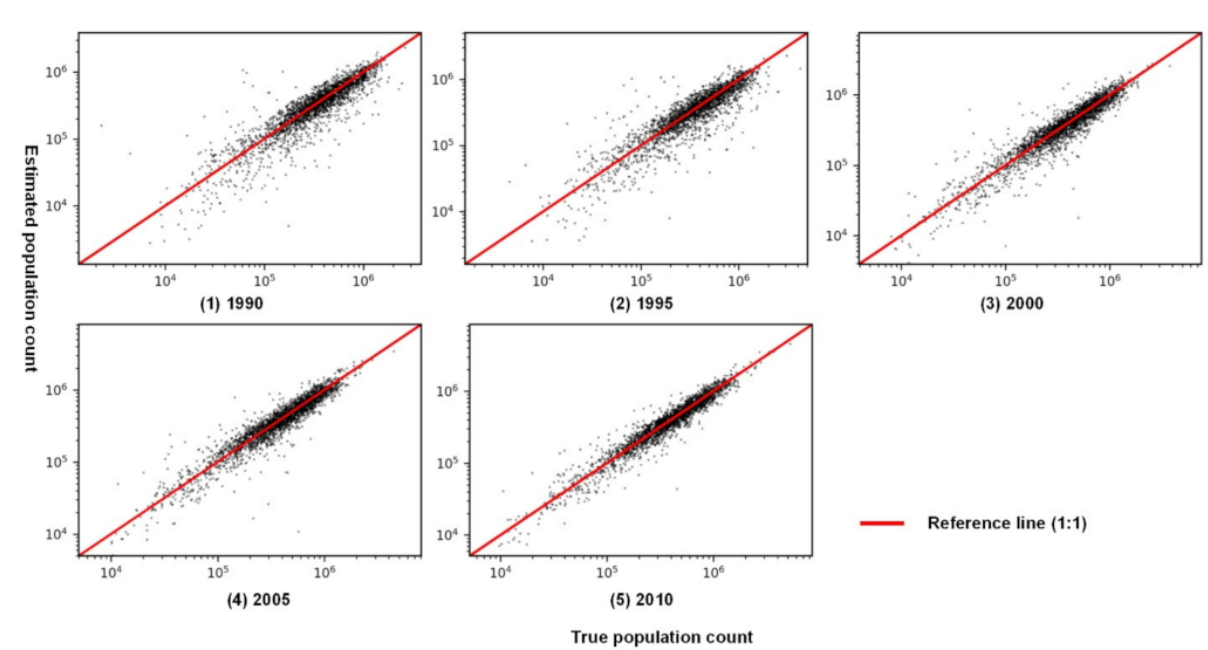
Figure 11. Scatterplots of the true population count and estimated population count at county scale from 1990 to